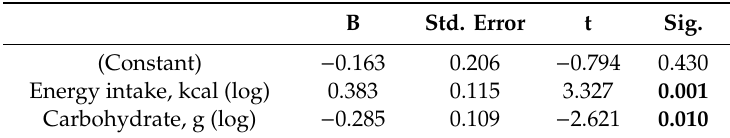
Table 6. Multivariable model predicting the BMI z-score, F (2, 90) = 5.652, p = 0.005, adj. R 2 = 0.092. p -values ≤ 0.050 are shown in bold.